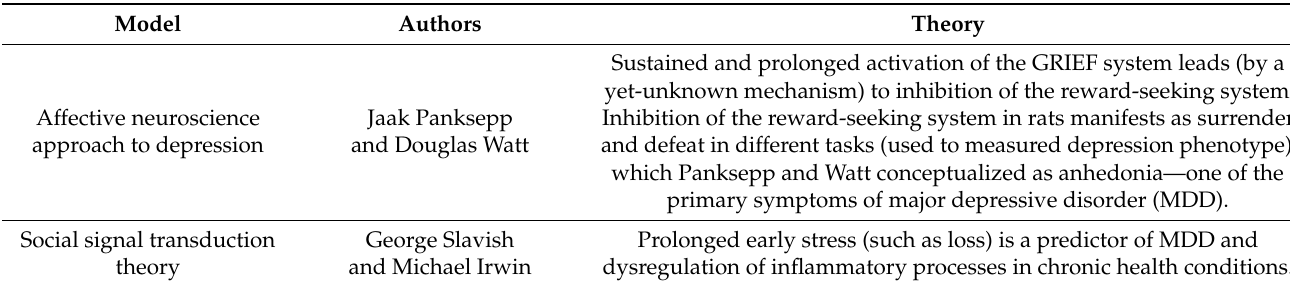
Table 1. Biopsychosocial approaches to loss associated with